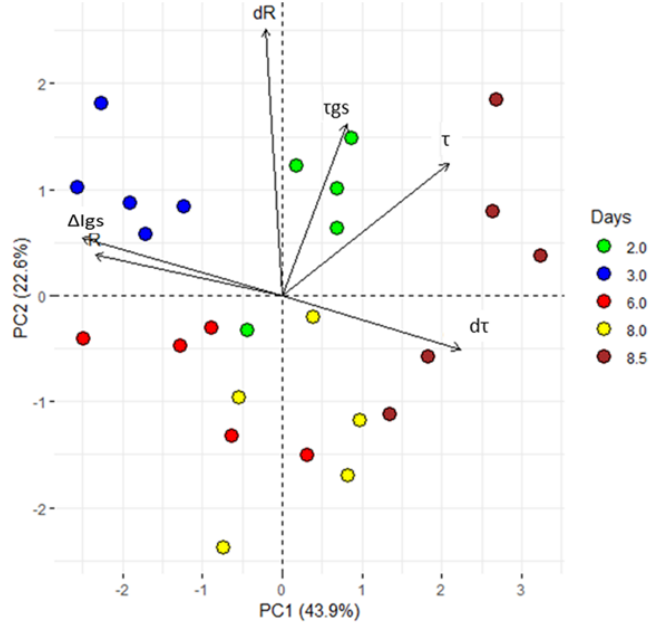
Figure 3. Principal component analysis (PCA). ∆I gs ; difference between minimum and maximum current gate values, τ and τ gs ; time constant. From the acquired data, the first derivative of R and τ (dR and dτ) was calculated. All values, exhibited clear separation between the groups with different periods of exposure to VPD variations (2, 3, 6, 8 and 8.5 dpi). The first two components PC1 and PC2 explain the 66.5% of the variability observed. Each dot represents a plant.